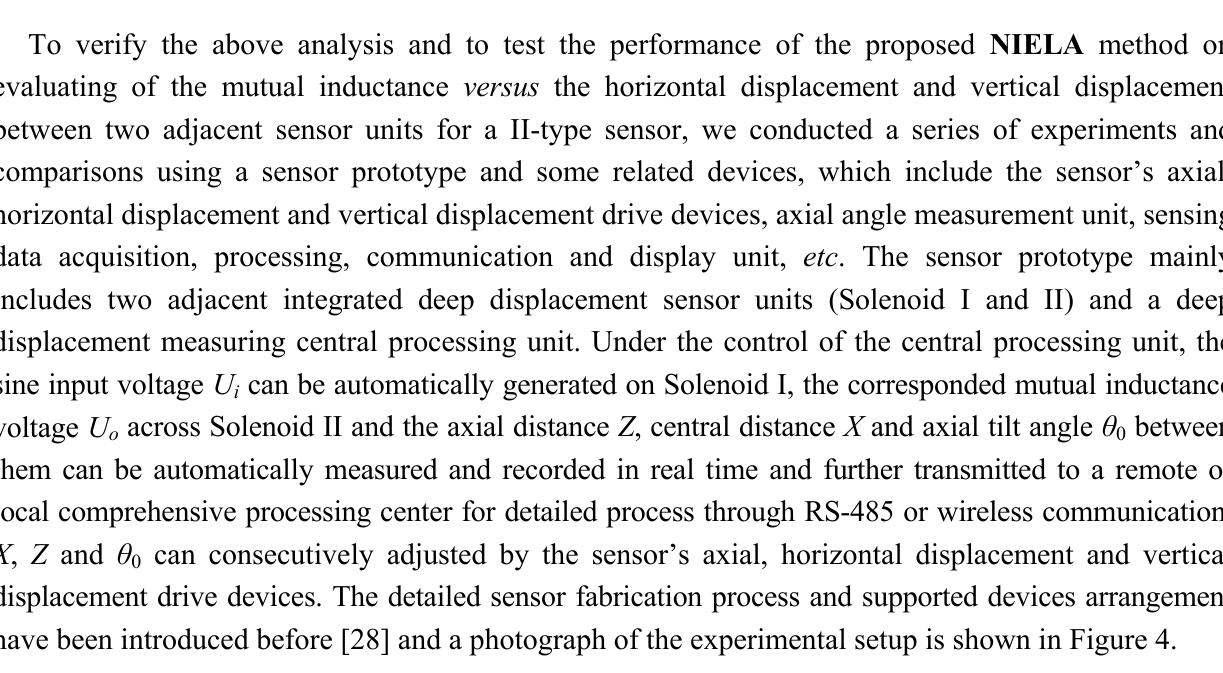
Figure 4. Photograph of the sensor prototype based experimental